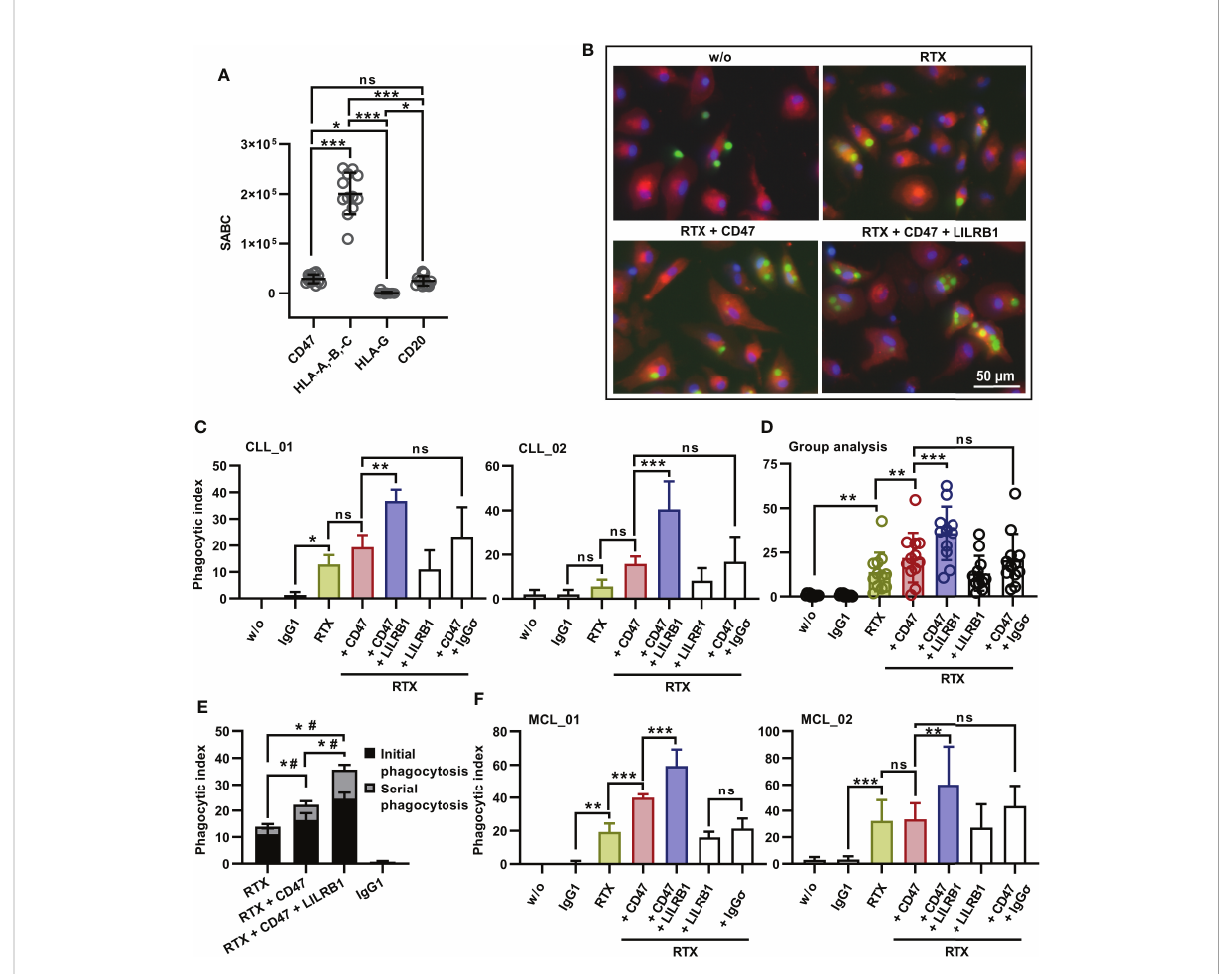
FIGURE 6 Enhanced ADCP of patient-derived CLL or MCL cells by dual checkpoint blockade of CD47 and LILRB1. (A) Cell surface expression levels of CD20, CD47, HLA-A,-B,-C and HLA-G by patient CLL cells was analyzed by calibrated fl ow cytometry. Data points represent speci fi c antibody binding capacity (SABC) for individual patient samples. The horizontal lines indicate mean values ± SD (*P ≤ 0.05; ***P ≤ 0.001; ns, not signi fi cant; one-way ANOVA with Tukey ’ s multiple comparison test. (B) CFSE-labeled CLL cells (patient CLL_05) were incubated with M0 macrophages (labeled with Cell Brite ™ Orange cytoplasmic membrane dye, E:T cell ratio: 1:2) in the absence (w/o) or in the presence of the antibodies rituximab (RTX), CD47-IgG s (CD47) and LILRB1-IgG s (LILRB1; each at a concentration of 10 µg/ml) as indicated for 2 h. Nuclei were stained with NucBlue ™ . ADCP was analyzed by fl uorescence microscopy. (C) CLL cells from patients CLL_01 and CLL_02 were labeled with CFSE and incubated with M0 macrophages without (w/o) or with antibodies trastuzumab (IgG1), rituximab (RTX), LILRB1-IgG s (LILRB1), CD47- IgG s (CD47) or HER2-IgG s (IgG s ) as indicated (each at a concentration of 10 µg/ml) for 2 h. ADCP was analyzed by fl uorescence microscopy. Bars represent mean phagocytic index values ± SD from three independent experiments using macrophages from different donors (*P ≤ 0.05; **P ≤ 0.01; ***P ≤ 0.001; ns, not signi fi cant; one-way ANOVA with Fisher`s LSD test). (D) Group analysis of ADCP summarizing results obtained with CLL cells from 12 different patients as target cells. ADCP was determined for the indicated antibodies or their combinations as described in (C) . Data points represent mean phagocytic index values for individual patient samples as determined in independent experiments using macrophages from different donors, as illustrated in Suppl. Figure 6. Bars indicate overall mean phagocytic index values ± SD (**P ≤ 0.01; ***P ≤ 0.001; ns, not signi fi cant; one-way ANOVA with S ̌ idàk´s multiple comparisons test). (E) LILRB1 and CD47 immune checkpoint blockade promotes serial ADCP of patient CLL cells by human M0 macrophages. Phagocytic events were assigned to phagocytosis of the fi rst CLL cell (initial phagocytosis) or to engulfment of subsequent CLL cells (serial phagocytosis) and are presented as a proportion of phagocytic index values. Bars represent mean values ± SEM. Statistically signi fi cant differences between treatment groups in initial phagocytosis (*) and serial phagocytosis (#) are indicated (P ≤ 0.05; two-way ANOVA and Tukey`s multiple comparison test; n = 12). (F) MCL cells were isolated from two patients, labeled with CFSE and analyzed as target cells for M0 macrophages in the presence of the indicated antibodies (each at a concentration of 10 µg/ml) by fl uorescence microscopy as described in (C) . Data points represent mean phagocytic index values ± SD from three (MCL_01) or six (MCL_02) independent experiments using macrophages from different donors (**P ≤ 0.01; ***P ≤ 0.001; ns, not signi fi cant; one-way ANOVA with Fisher`s LSD